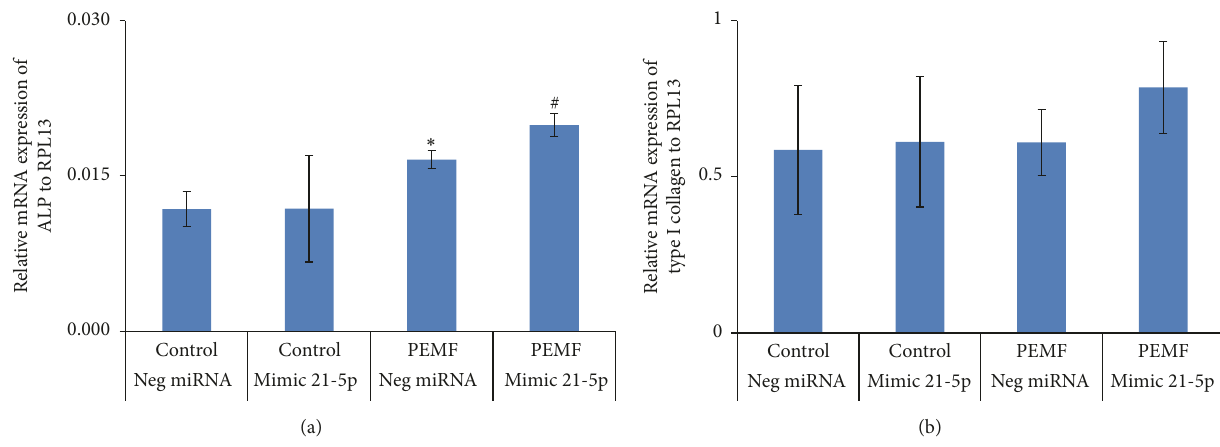
Figure 7: PEMF resulted in stimulation of expression of ALP mRNA and its effect was further enhanced by miR21-5p. Human BMSCs from a 31-year-old female were transiently transfected with 50 nM of negative control miRNA or miR-21-5p mimic for 72 h in osteogenic medium and PEMF treatment was carried out for 4h each day for a total of 6 days. Total RNA was isolated and RT-qPCR was carried out using the primers for ALP (a) and collagen 1A1 (b) genes. Expression of the mRNAs is shown relative to the RPL13 gene. 𝑛 = 3 . ∗ indicates significant increase compared to negative control miRNA transfection. # indicates significant increase compared to all treatments. Analysis by one-way